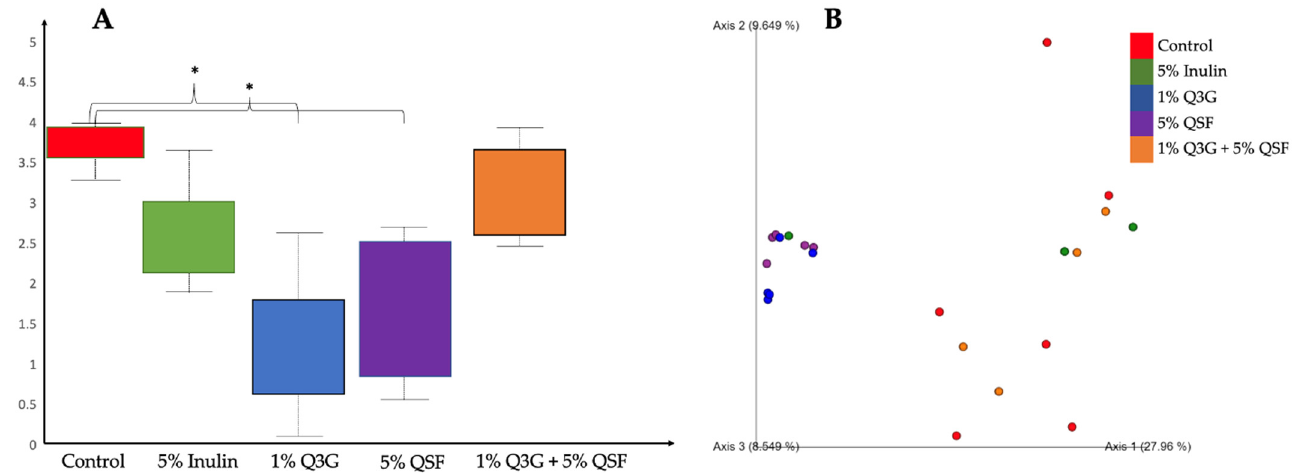
Figure 4. Cecum bacterial population analysis. ( A ) Measure of α -diversity using Shannon’s diversity index, the q value was established using Kruskal–Wallis (pairwise) test; ( B ) Principal Coordinate analysis (PCoA) showing β -diversity using the Bray–Curtis index, PERMANOVA (pairwise) test for statistical significance. n~5, * = q < 0.05. Q3G, quercetin 3-glucoside; QSF, quinoa soluble fiber.